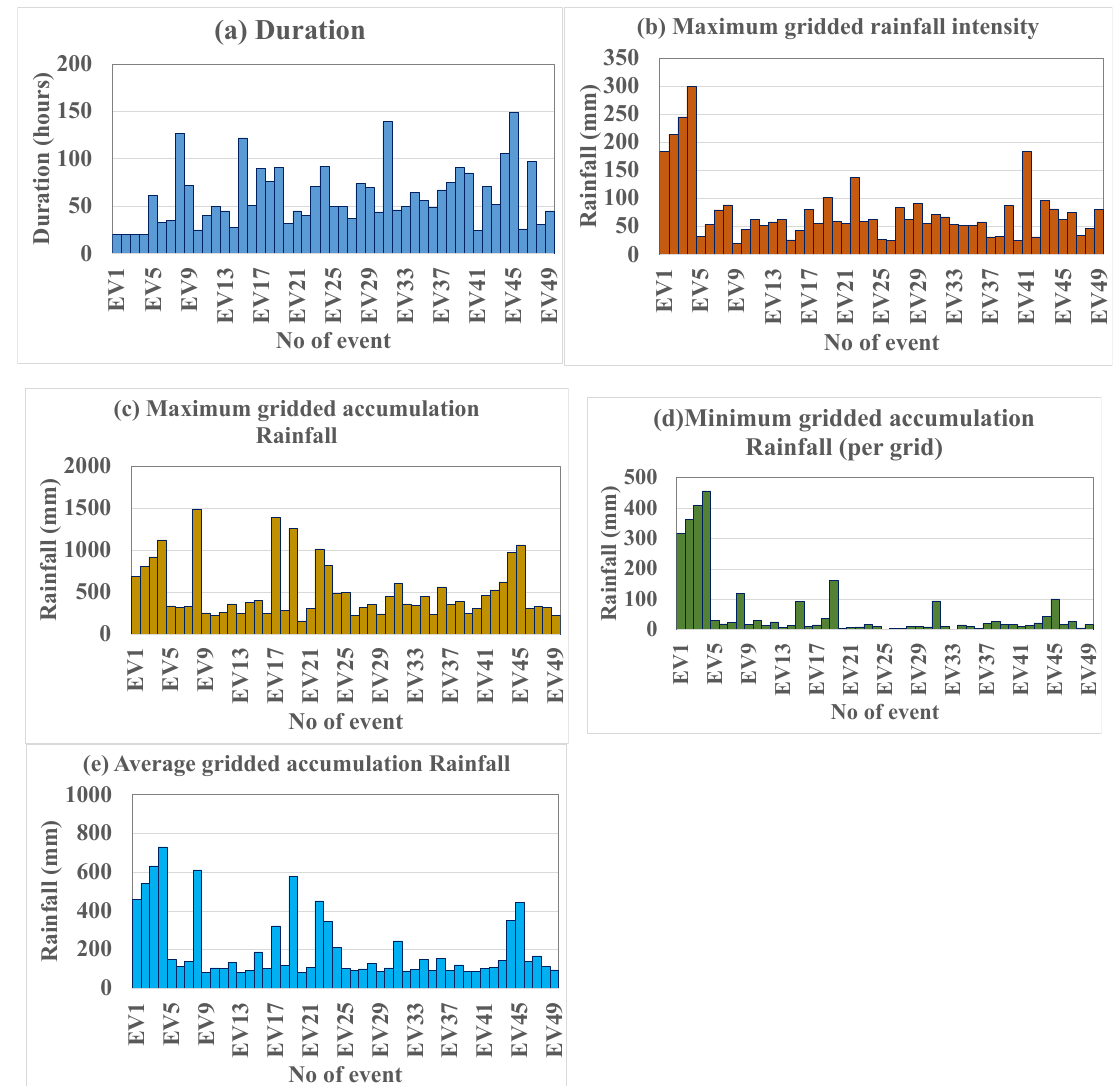
(b) Maximum gridded rainfall intensity